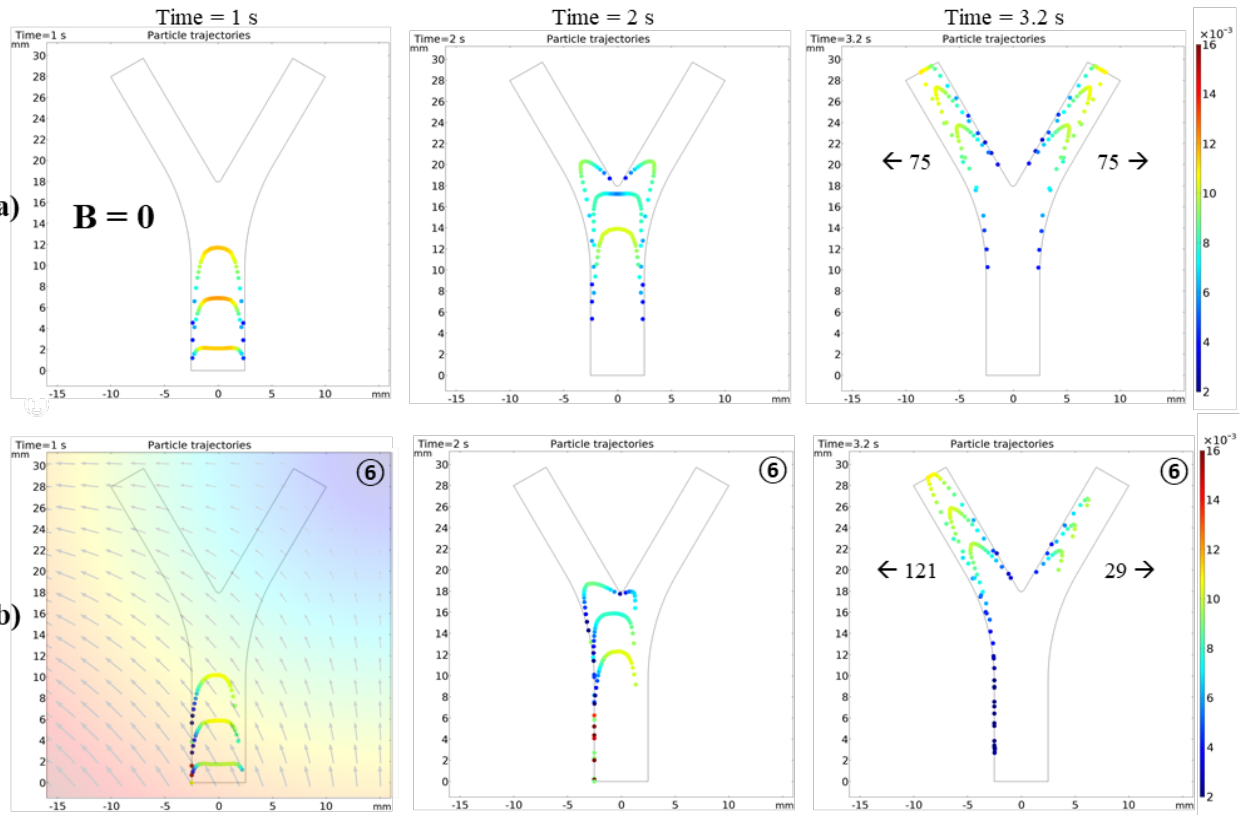
Figure 3. ( a ) Particle trajectories without any external magnetic field influence; ( b ) FFP at position ⑥ . Table 1. Simulation